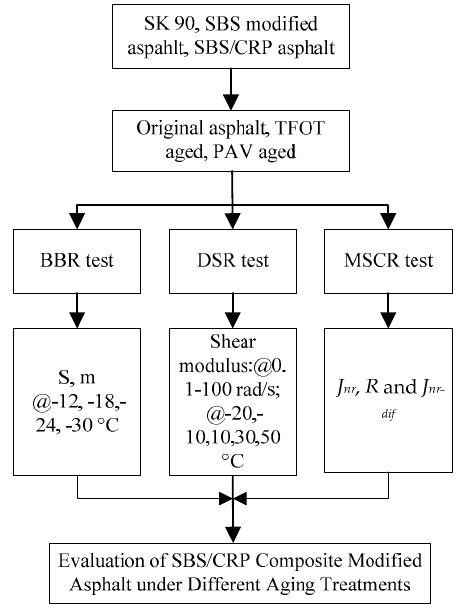
Figure 1. Test schematic of this study.